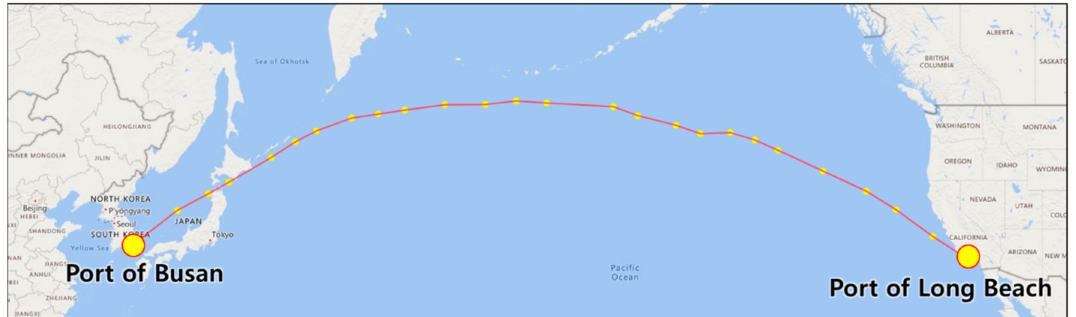
Figure 9. Ship route for application.